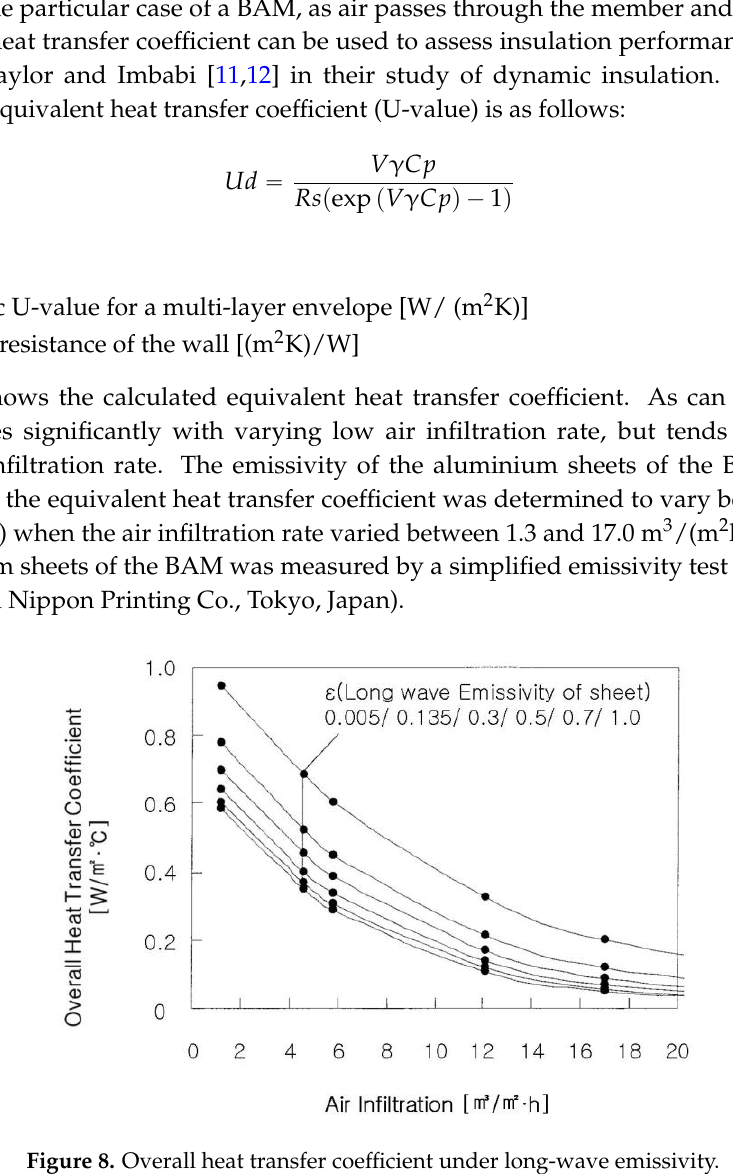
Figure 9. Combination of BAM design and ventilation rate prediction